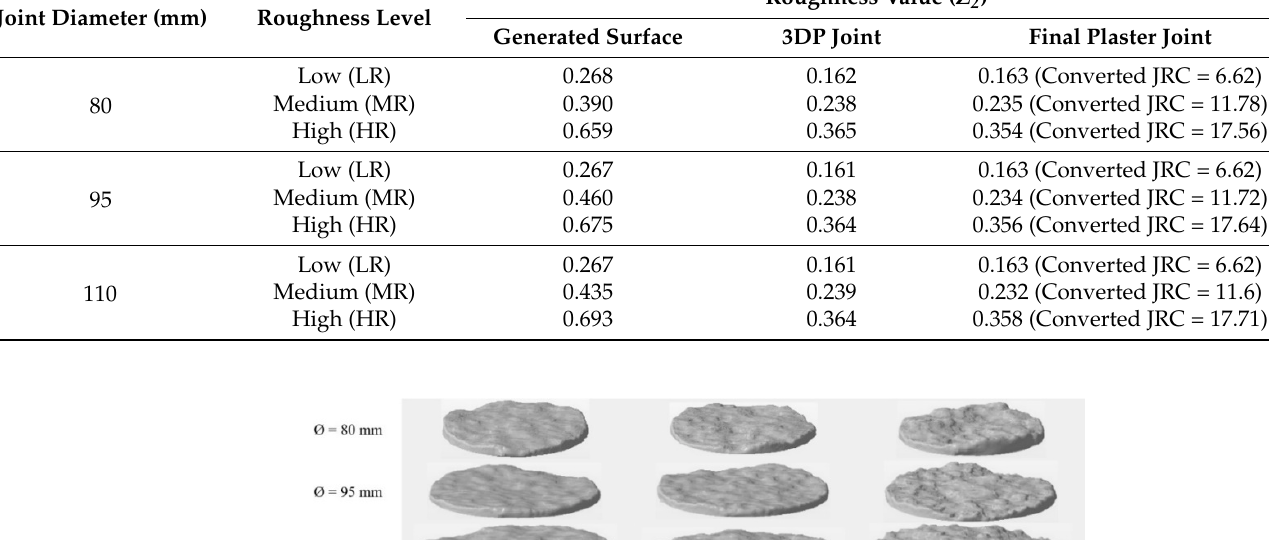
Table 3. Roughness properties of generated, 3DP, and final plaster joint surfaces.